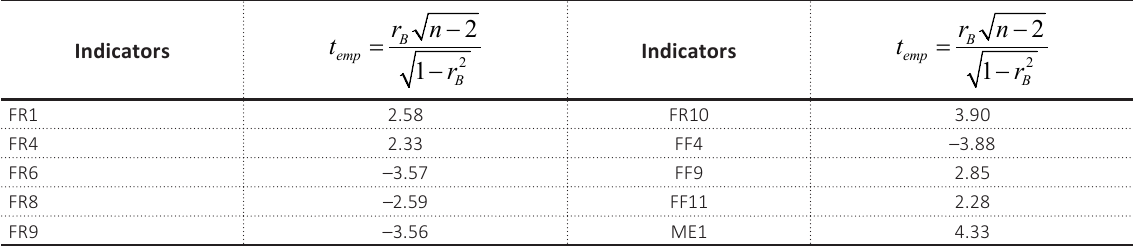
Table 3. Checking the significance of paired correlation coefficients